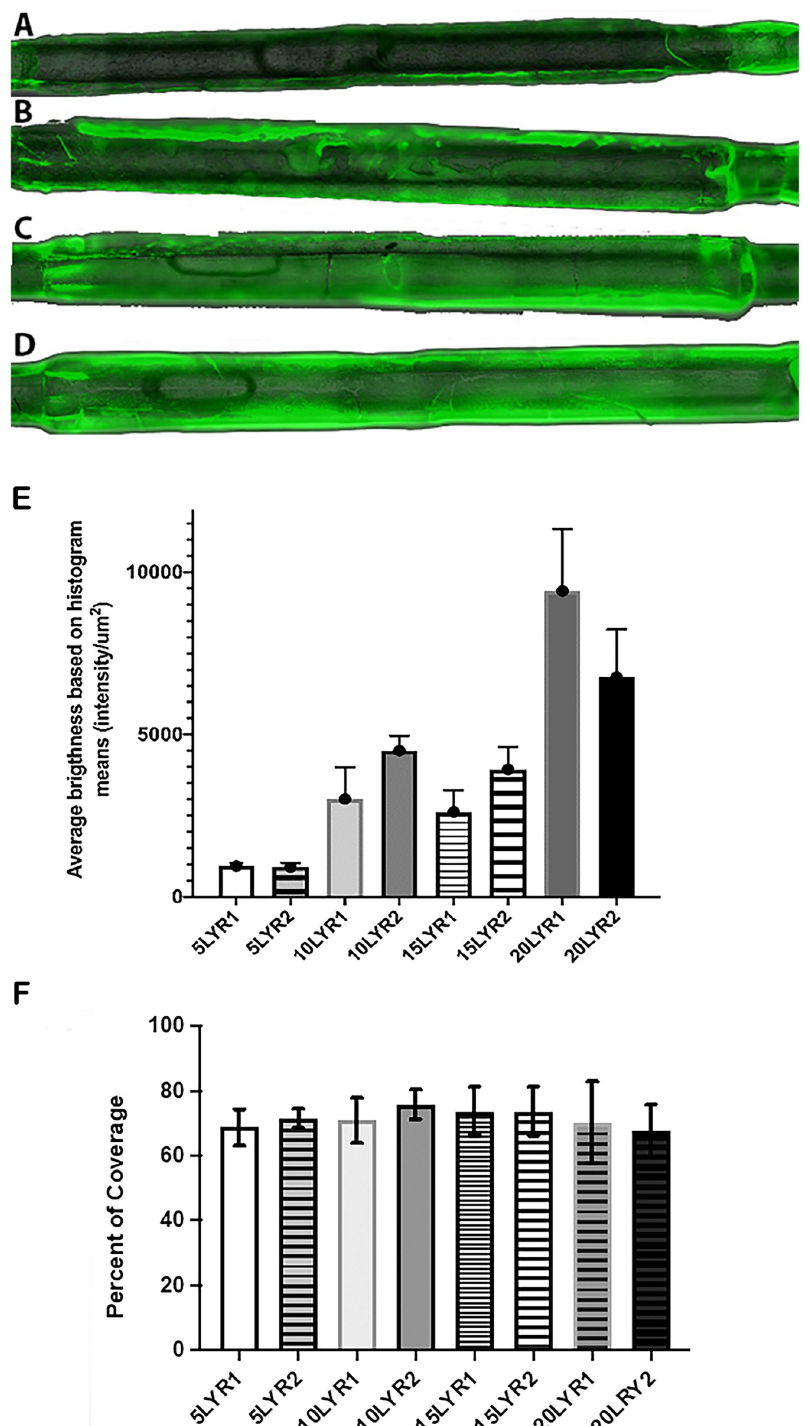
Fig 10. Fluorescence imaging revealed that ultrasonic coating with pNPs entrapping polyphenols yields uniform coatings. A) Example of stitched images used to reconstruct the balloons for image analysis. Shown are representative balloons coated with 5 (A), 10 (B), 15 (C), and 20 layers (D) of pNp coating, visible + fluorescent green overlay (at 75% opacity). E) Overall mean fluorescence and corresponding standard deviations for n = 8 samples (balloons ultrasonically coated). Data illustrated in the graph represent mean fluorescence ± SD (in unit of brightness per μ m 2 ).